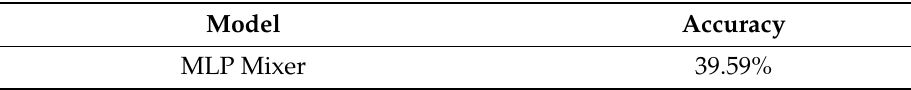
Figure 5. MLP Mixer: test loss. Table 4. MLP Mixer performance in artwork style recognition.